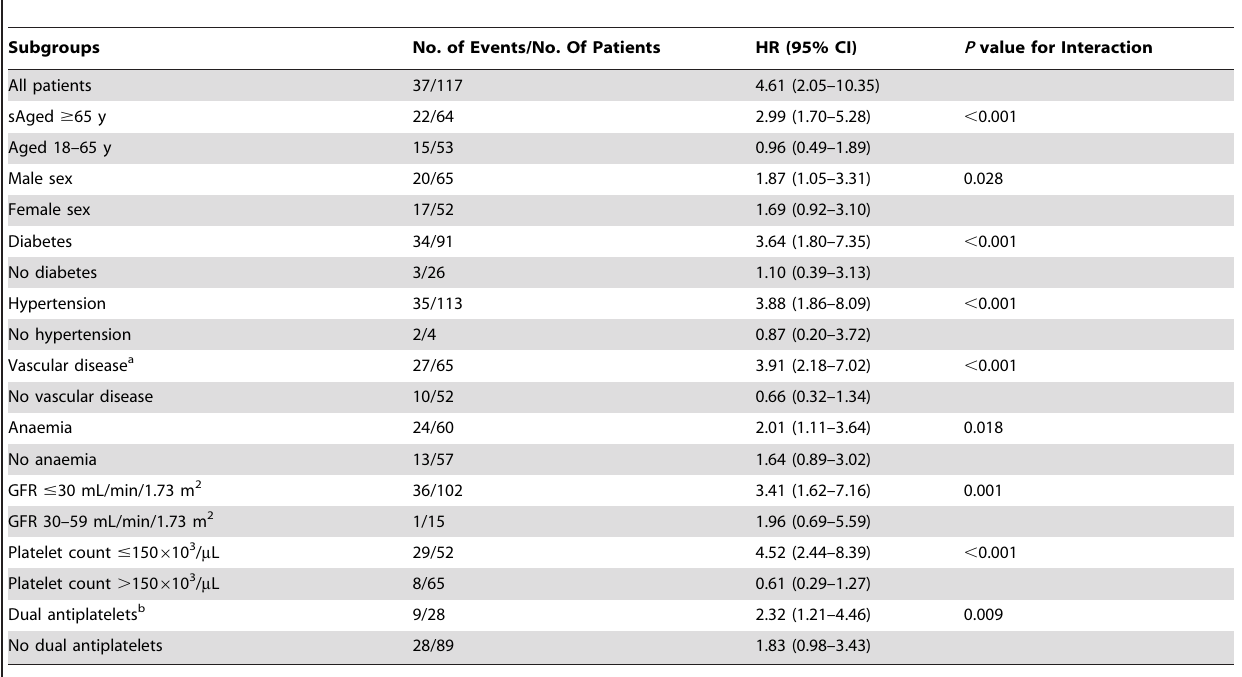
Table 5. Hazard ratios of major bleeding events with anticoagulant use stratified by cohort characteristics.